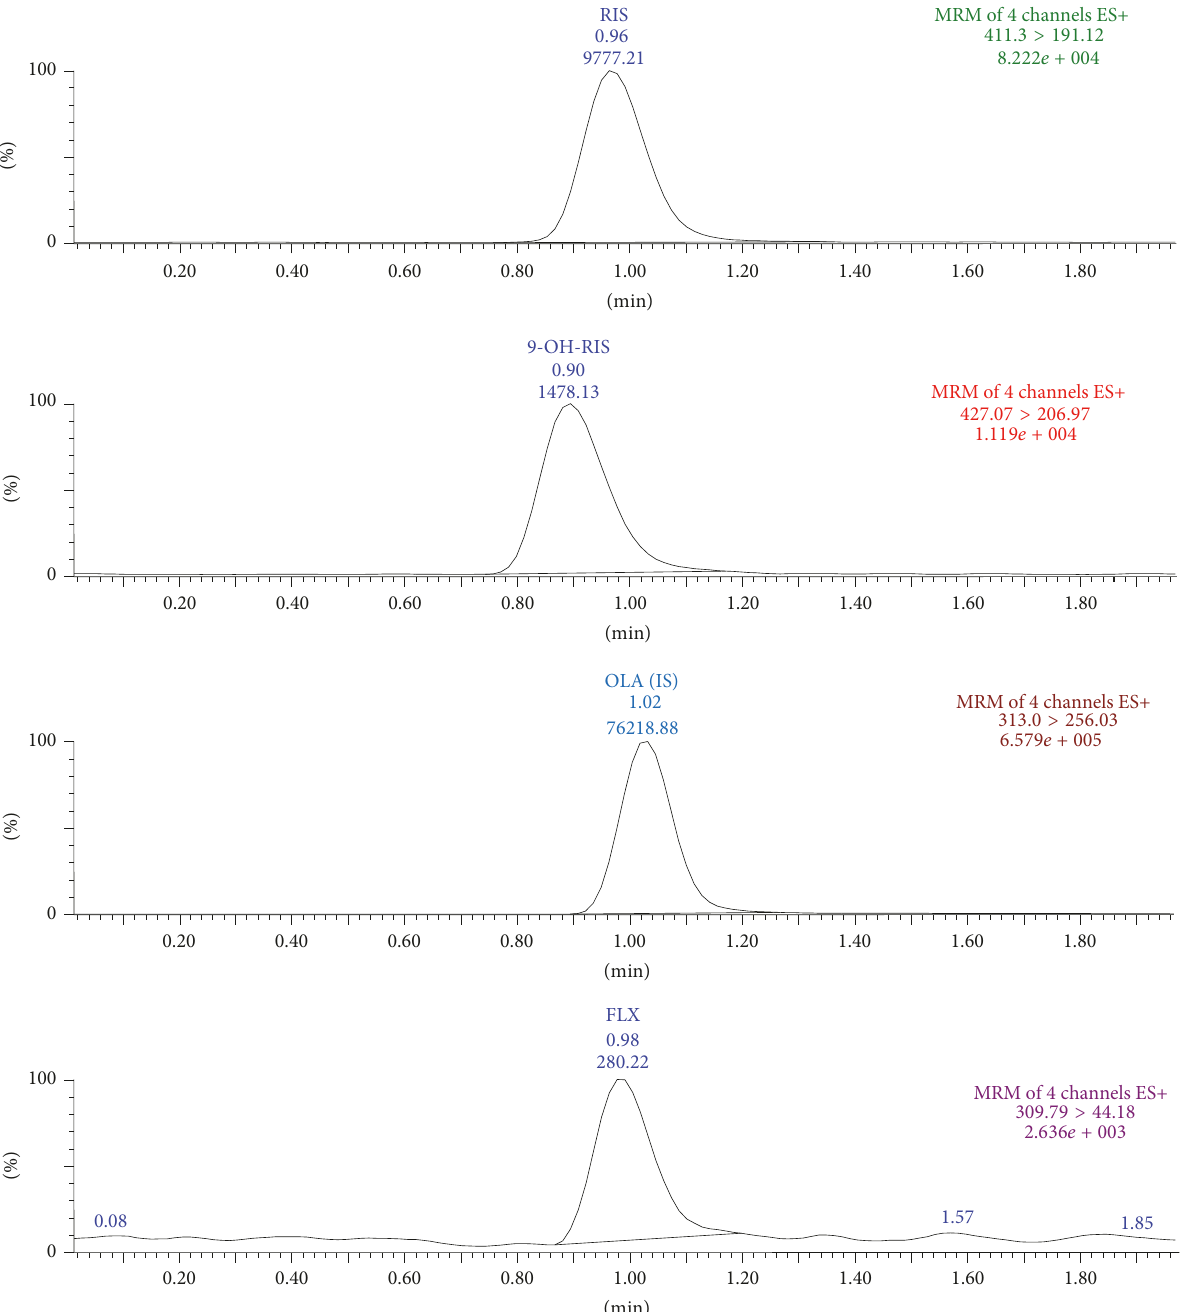
Figure 6: MRM chromatogram of plasma sample from a rat at 1hr after administration of oral dosing of 10mg/kg of FLX and 0.3 mg/kg of